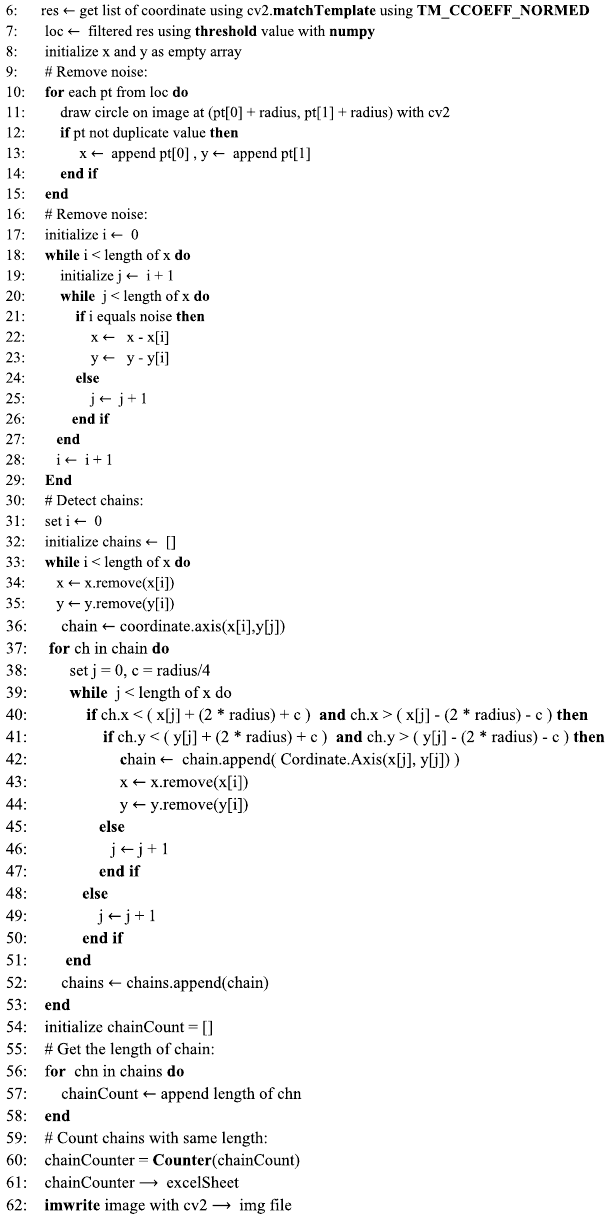
Predictors of our model were extracted from the micrographs (Fig. 2). The value of each predictor is the number of microparticles in a pearl chain at an applied voltage. Pearl chain count, C L where L sents the number of pearl chains of a specific chain length L , C L values for all images taken at different voltages are stored in as a matrix and used as features or predictors in order to represent the DEP force. The pearl chain formations were recorded at different voltages. We hypothesize that pearl chain counts C L in a micrograph